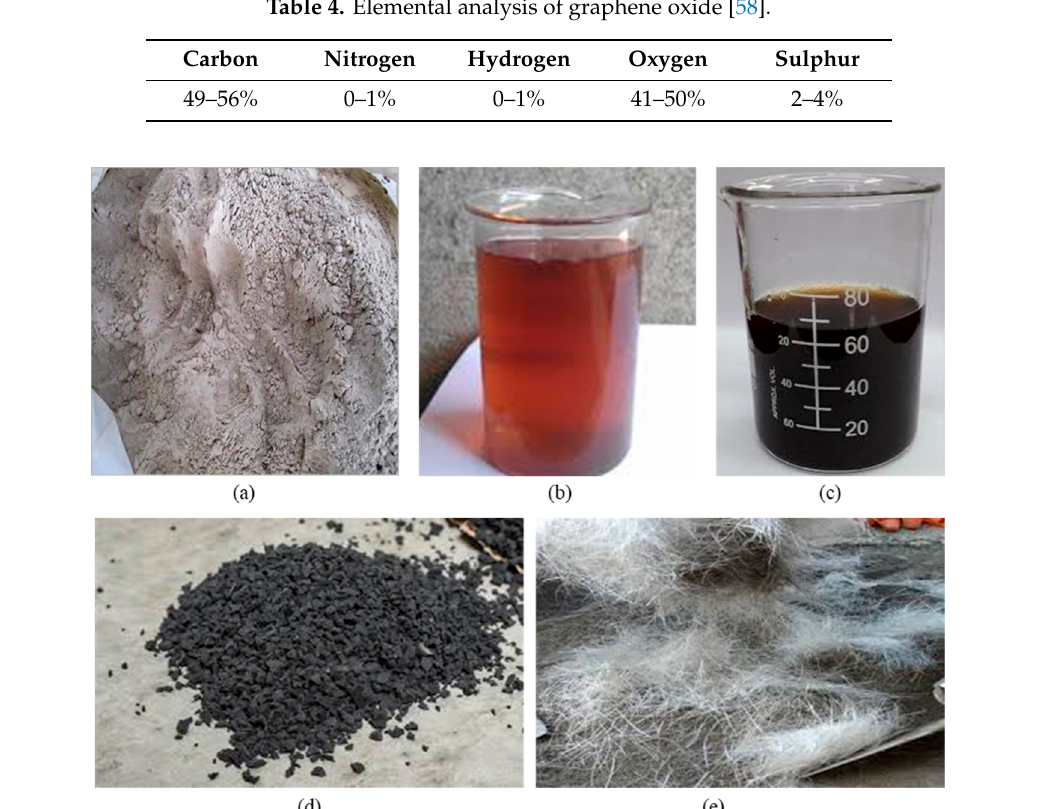
Figure 1. Materials used: ( a ) class F fly ash; ( b ) superplastisizer (Sika Viscocrete-2044); ( c ) graphene oxide; ( d ) crumb rubber; and ( e ) PVA.